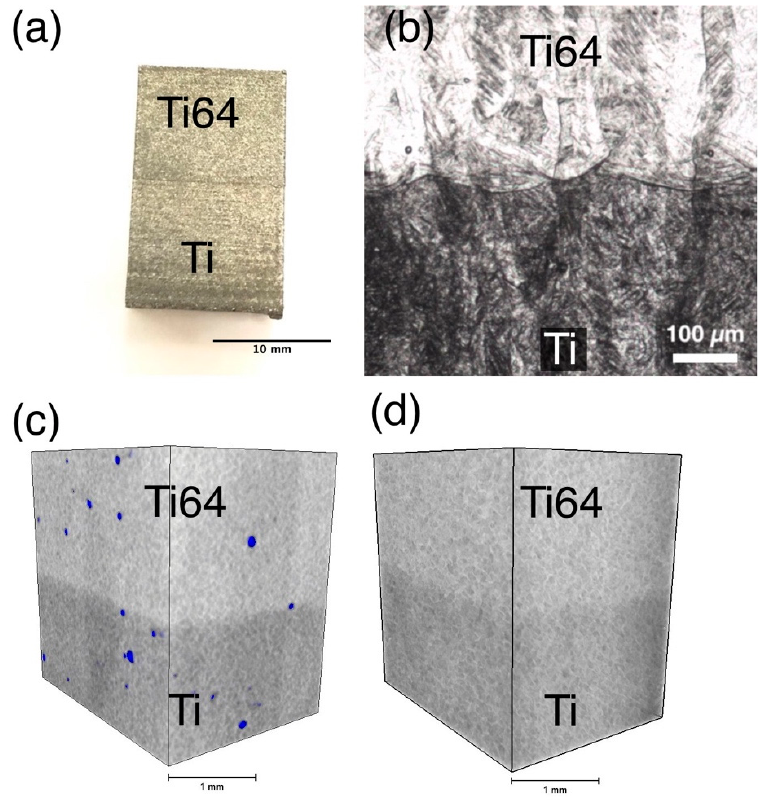
Figure 3. ( a ) A photograph of the Ti/Ti64 sample, ( b ) microstructure of the transition zone, ( c ) as-built, and ( d ) HIPed specimens’ volume obtained by CT-reconstruction.